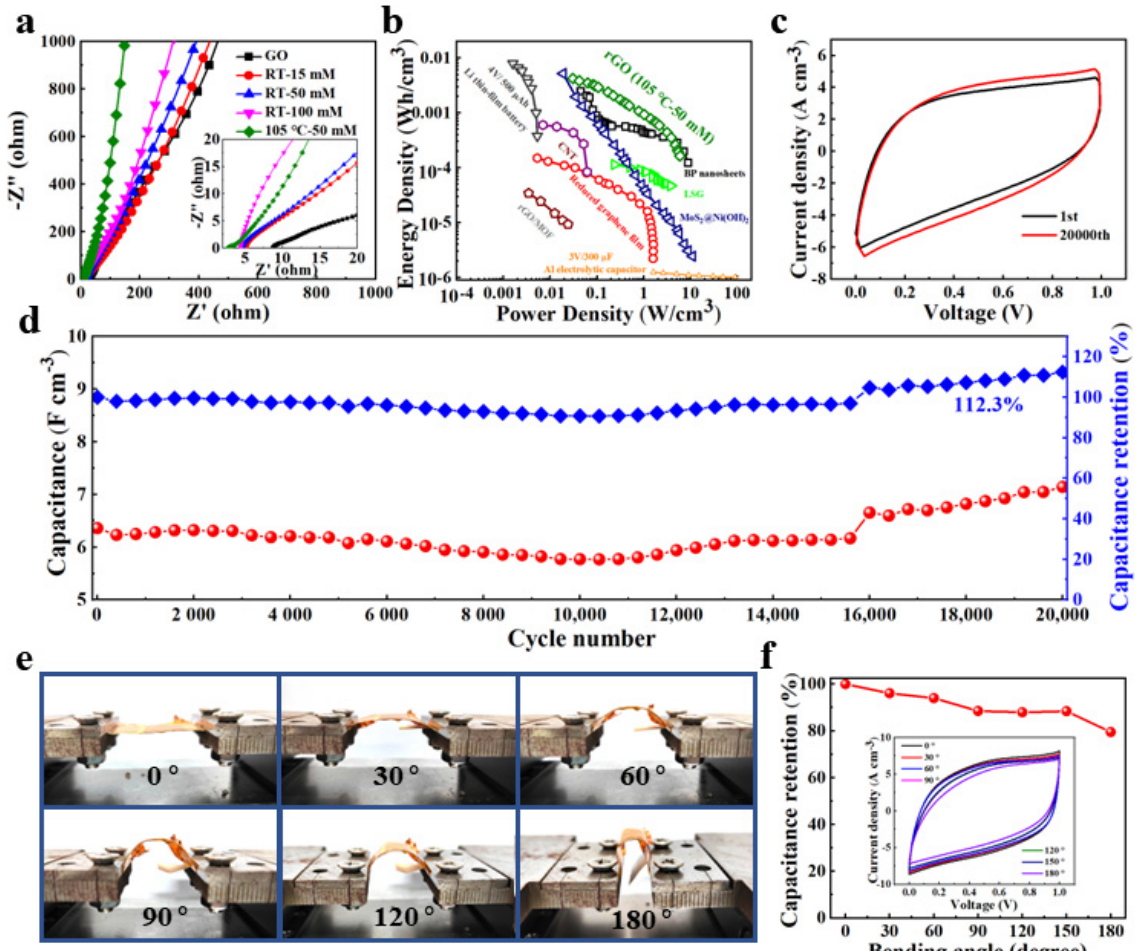
Figure 5. ( a ) Nyquist plots of GO, RGO-RT-15 RGO-RT-50, RGO-RT-100, and RGO-105-50. ( b ) Ragone plot of RGO-105-50 in comparison with commercial energy storage systems and reported superca- pacitors. ( c ) Comparison of CV curves of RGO-105-50 supercapacitor at the 1st cycle and 20,000th cycle. ( d ) Cyclic stability of RGO-105-50 supercapacitor over 20,000 cycles at 0.5 V s − 1 . ( e ) Digital photographs of RGO-105-50 supercapacitor at different bending states. ( f ) The capacitance retention of RGO-105-50 supercapacitor measured at 0.5 V s − 1 . The inset shows the basically coincident CV profile of RGO-105-50 supercapacitor.